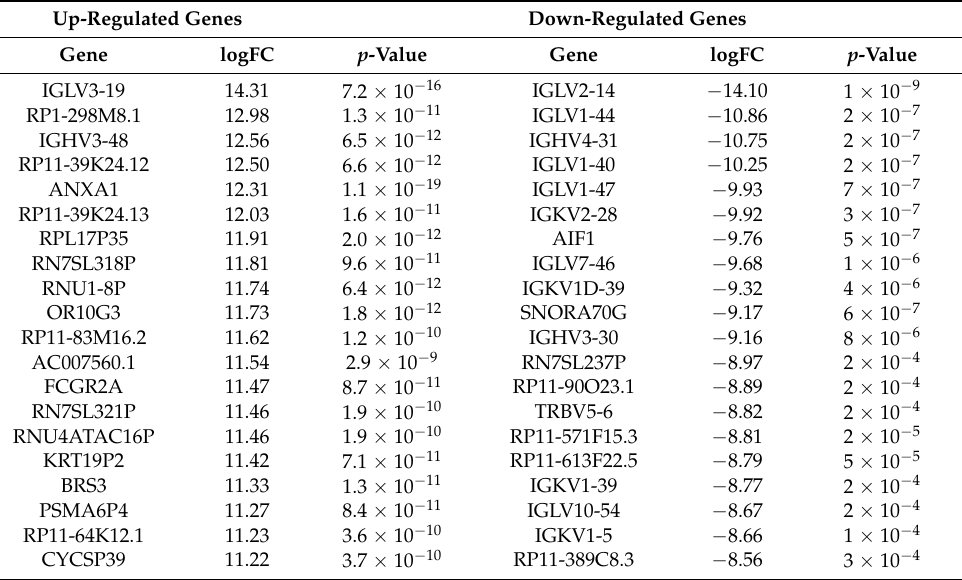
Figure 2. ( a ) PCA plot of samples showing distribution of each samples. ( b ) Volcano plot of differentially expressed genes. ( c ) Heatmap of gene expression in metastatic and non-metastatic samples. Table 1. Fold change of genes by differentially expressed gene assay. The top-20 most up/down regulated genes by comparing non-metastatic breast cancer with metastatic breast cancer.